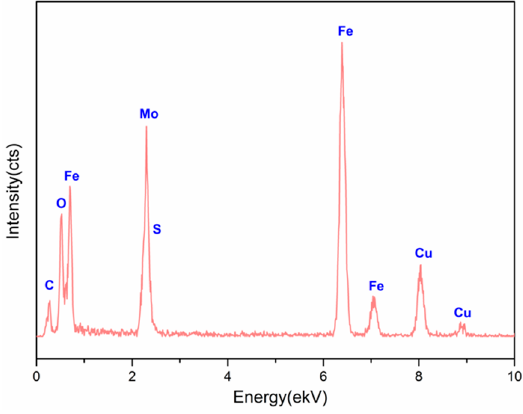
Figure 5. EDS of MFNNs in the region of Figure 4c.